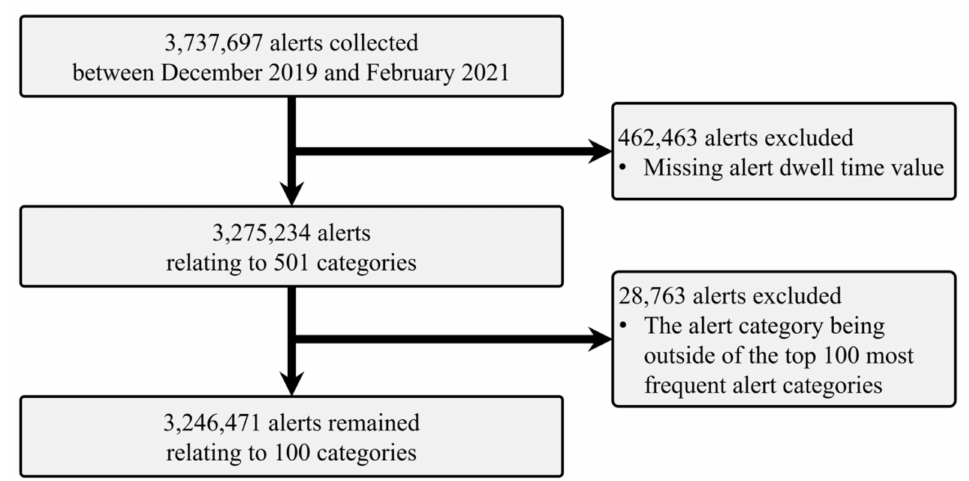
Figure 4. Schematic outline of inclusion and exclusion criteria in this study.